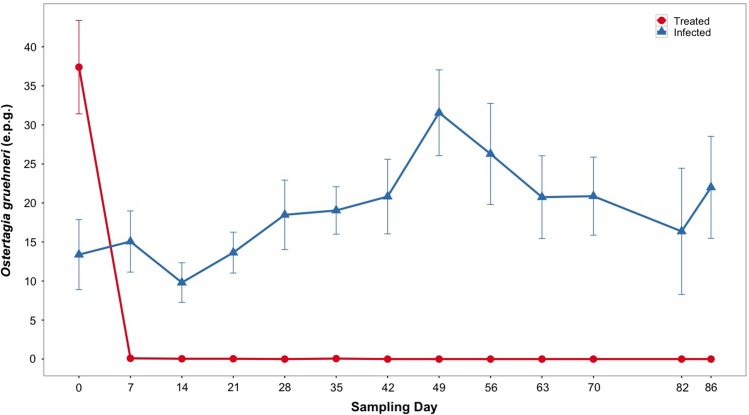
Reindeer treated with moxidectin (red circles and red line) had significantly lower parasite (Ostertagia gruehneri) intensity compared with infected reindeer (blue triangles and blue line) from day 7 onward. Parasite intensities (measured as eggs per gram of faeces; e.p.g.) are represented here as a mean value (±SEM) for each sampling day.